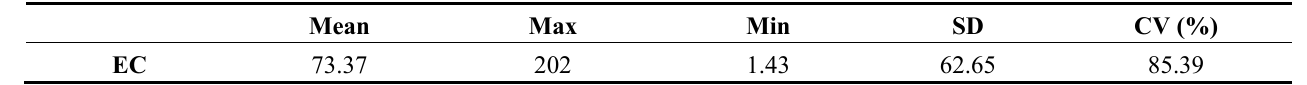
Table 2. Descriptive statistics of electrical conductivity (EC).